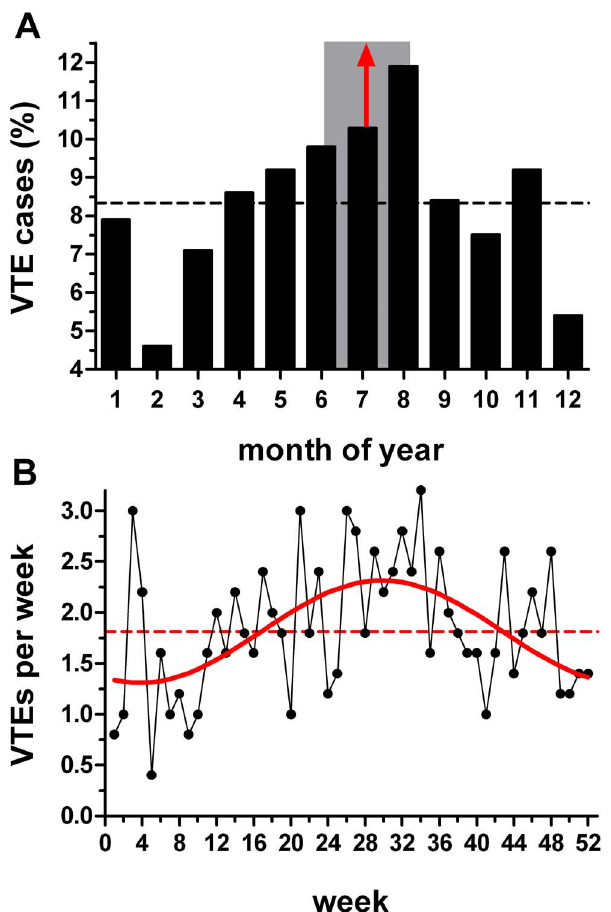
Figure 7. Distribution of non-idiopathic venous thromboem- bolism (VTE). (A) Monthly distribution (January=1): dashed line indicates uniform distribution. Distribution differed from uniform ( P , 0.05 Kuiper’s test; P =0.0004 Rayleigh test); mean (red arrow)=July 21 st (shaded rectangle indicates the 95% confidence intervals; June 21 st to August 20 th ). (B) Weekly distribution. Solid red line shows the periodic regression ( P =0.0004; R 2 =0.27); July 25 th peak.